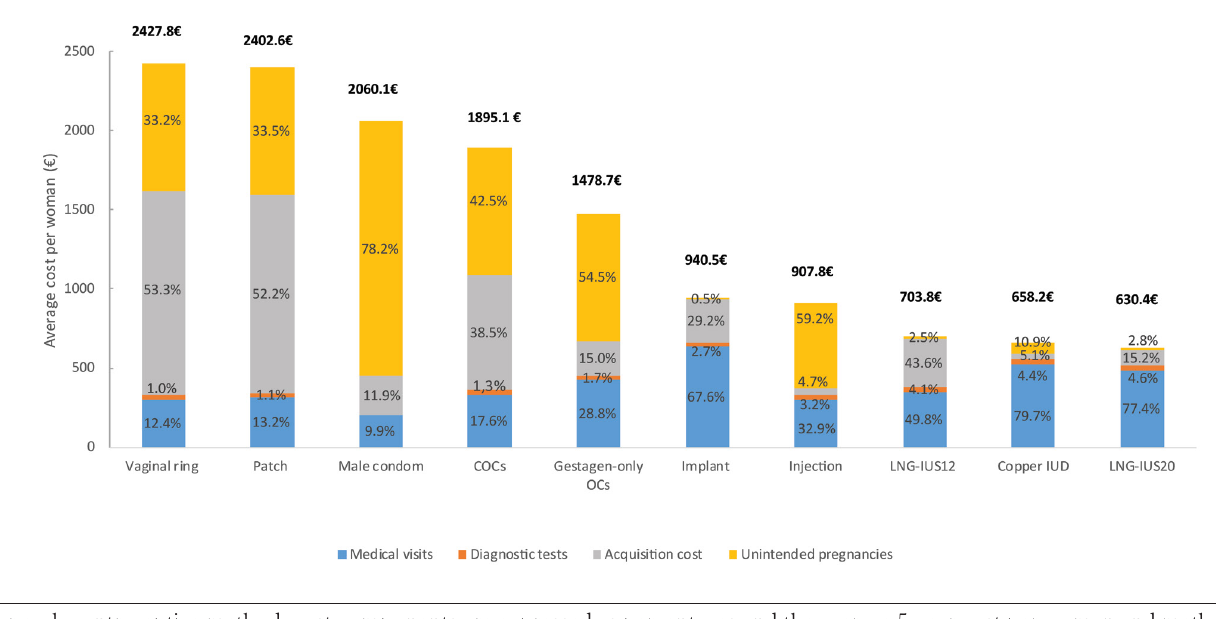
For each contraceptive method, cost components are expressed as percentages and the average 5-year cost per woman and method is shown in